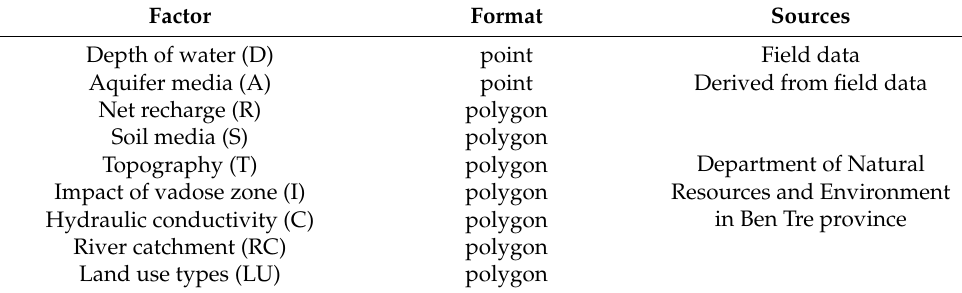
Table 1. Data used for mapping the parameters of the model. Factor Format Sources Depth of water (D) point Field data Aquifer media (A) point Derived from field data Net recharge (R)